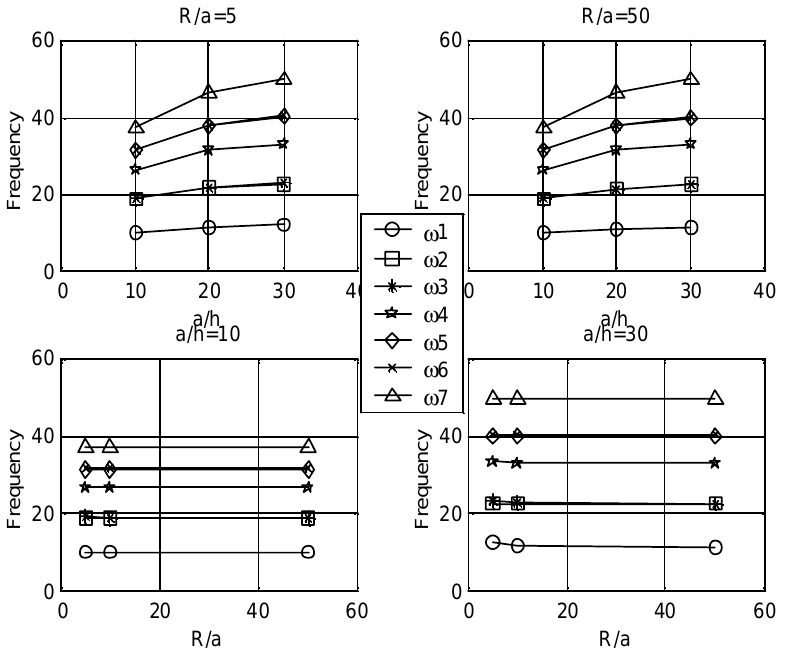
Fig. 4. Normalized natural frequencies for isotropic cylindrical panel ( b/a = 1) with different a/h and R/a . E 1 = E 2 = 10000 MPa , ν 12 = ν 21 = 0 . 25 and G 13 = G 23 = G 12 = 4000